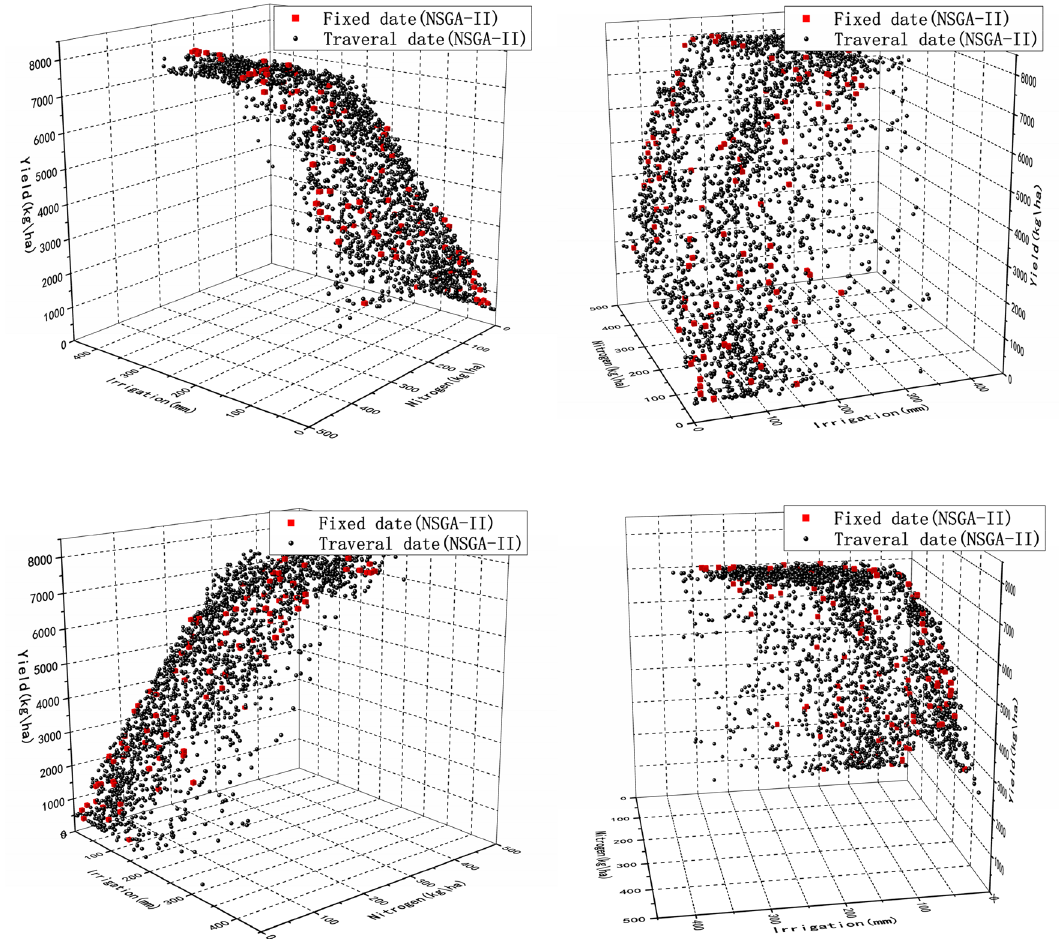
Figure 8. Optimization of yield, irrigation, and nitrogen application by traversing fertilizer application